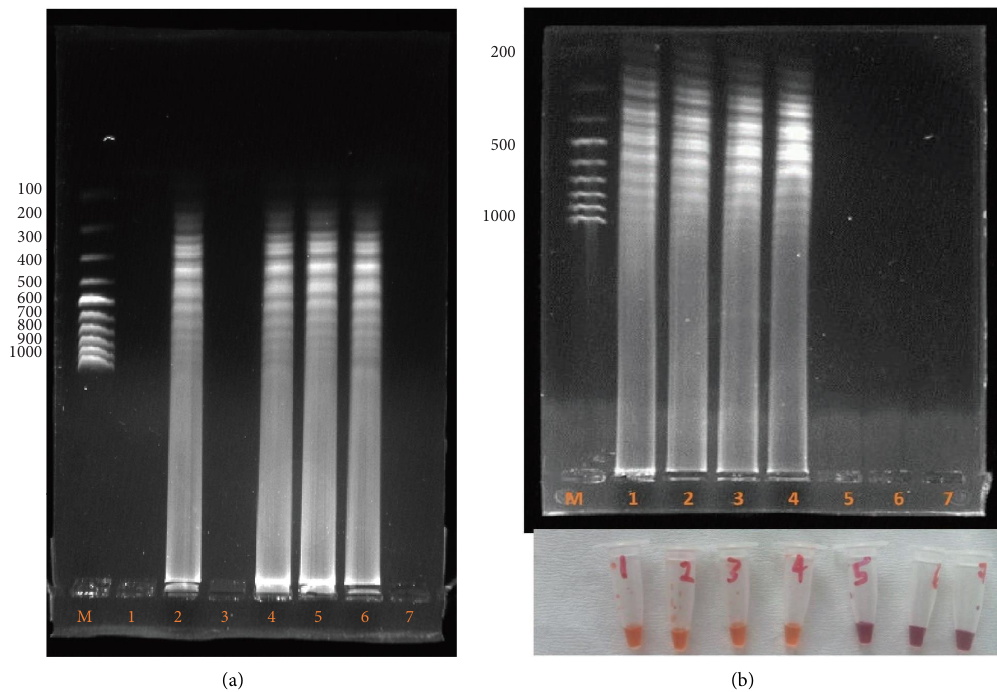
Figure 7: (a) Efect of loop primers (LP) on sensitivity and incubation duration. M-molecular ladder, 1 ‒ 30 minutes without LP; 2 ‒ 30 minutes with LP; 3 ‒ 45 minutes without LP; 4 – 45 minutes with LP; 5 – 60 minutes without LP; and 6 – 60 minutes with LP. (b) Specifcity of the colorimetric- RVFV-UDG-RT-LAMP assay. M-100bp molecular ladder, 1 – 4 RVFV strains G66, 1983, 5335, and G64, 5 -PPR, 6 -Capripox, 7